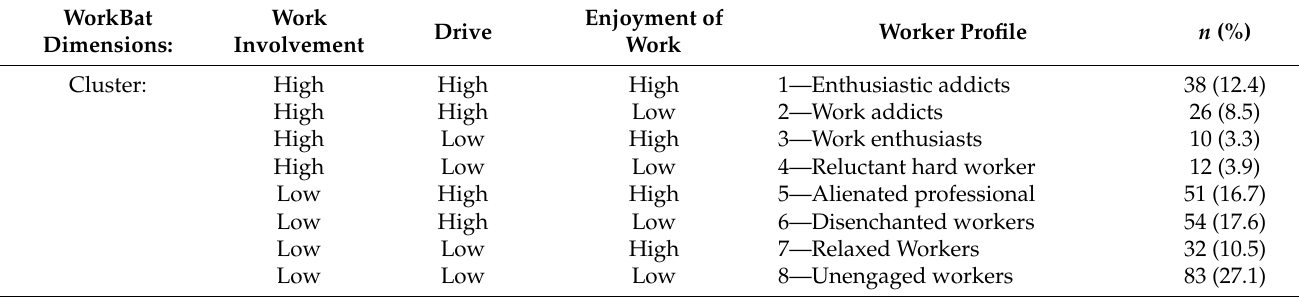
Table 5. Complete Spence and Robbins’ typology (Spence and Robbins 1992) of worker profiles: samples’ n and %. WorkBat